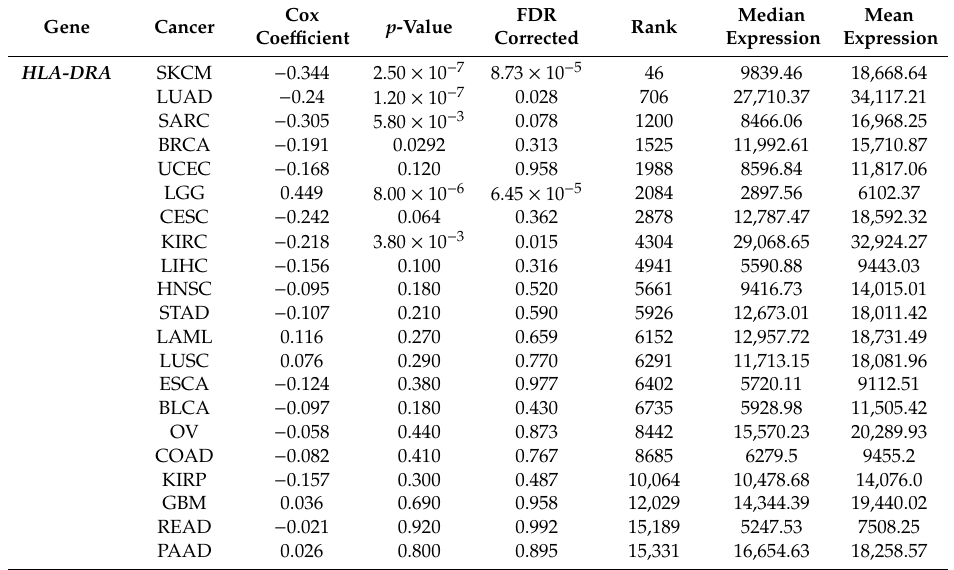
Table 4. Association of HLA-DRA expression in cutaneous melanoma with survival were compared across cancer